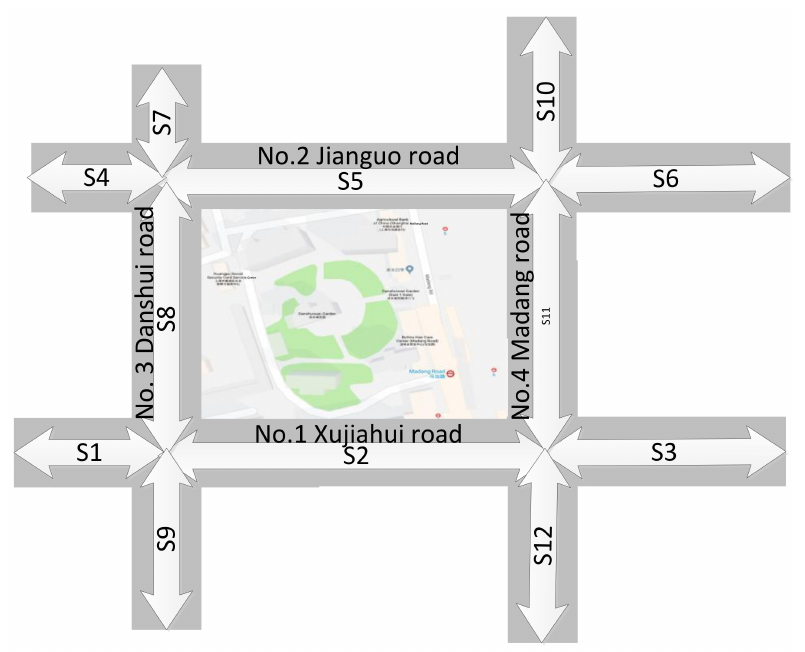
Figure 3. Boundary road network